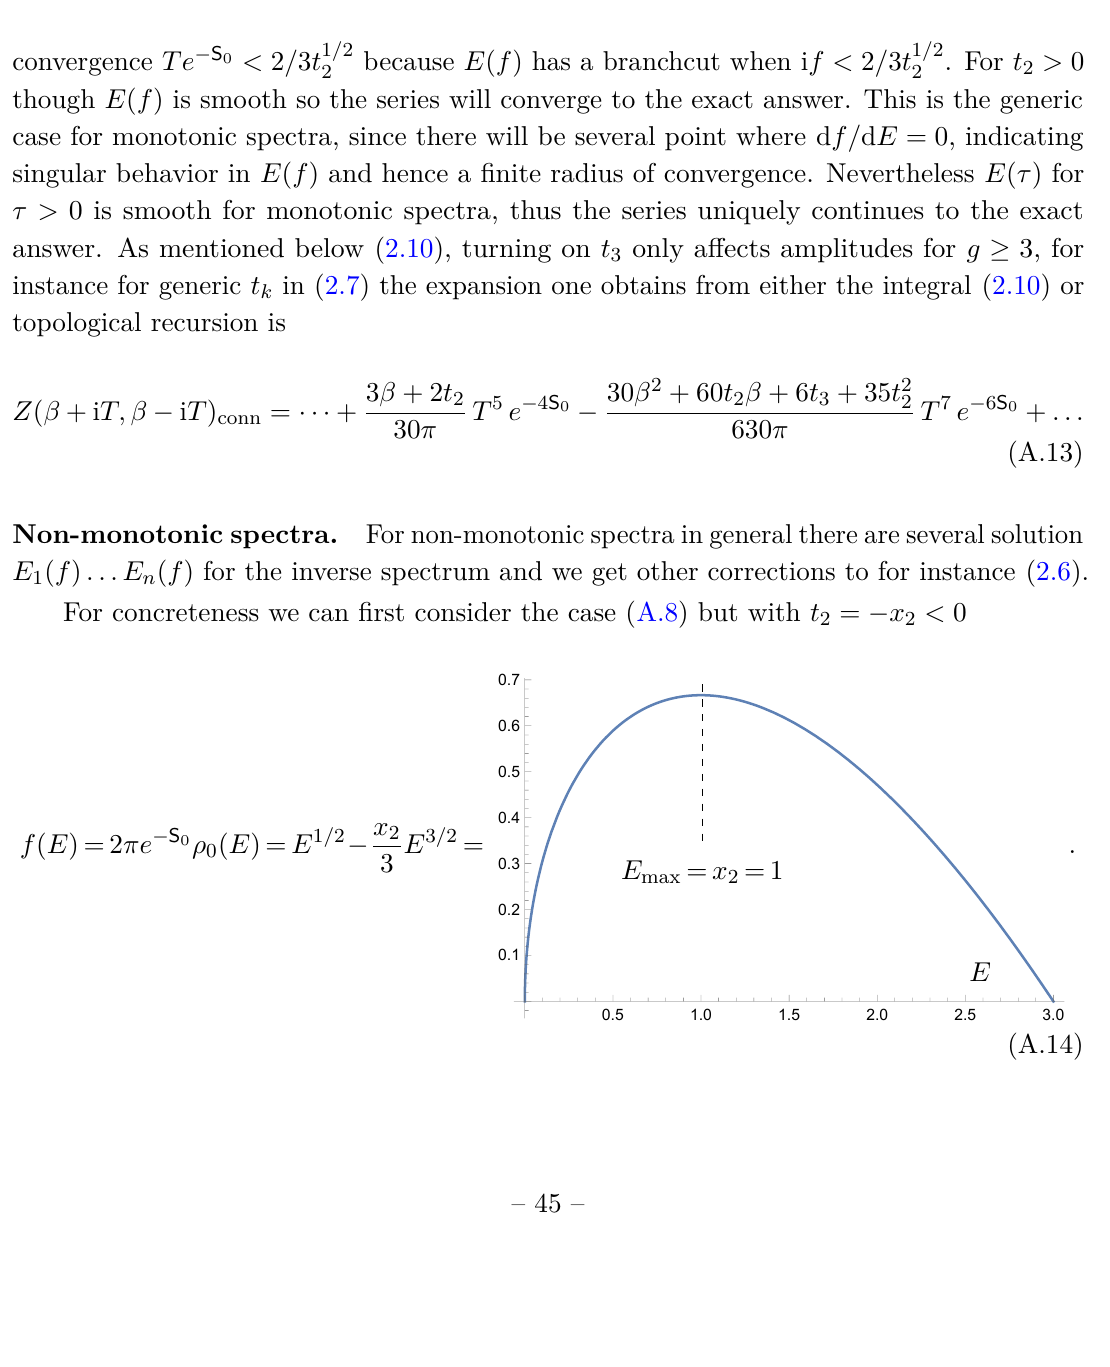
Figure 6 . The τ -scaling limit of the sum over wormholes in the (2 , 3) minimal model (A.8) with t 2 = 1 , e S 0 = 10 and β = 1 / 2 . The series expansion converges to the exact answer for T < 2 e S 0 / 3 t 1 / 2 = 20 / 3 and diverges otherwise, but the resummed series has a unique analytic 2 continuation which reproduces the exact answer for all T > 0